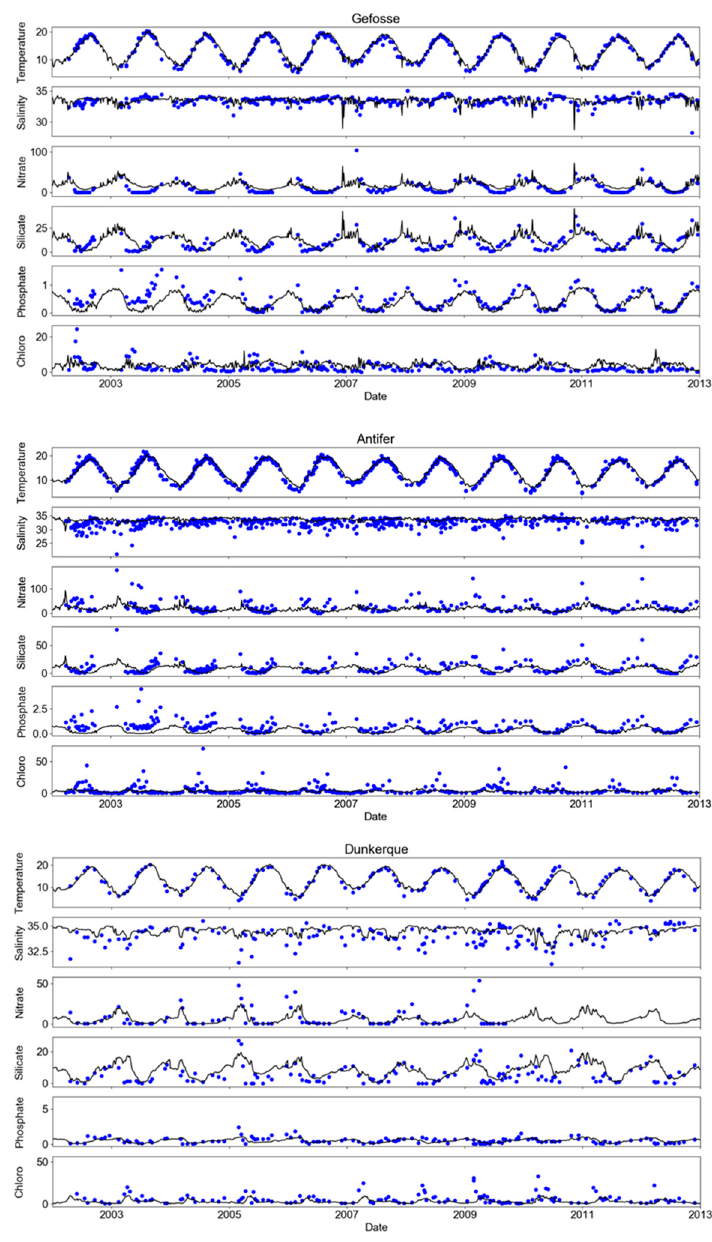
Figure 6. Seasonal and inter-annual variations of major quality variables at the coastal zone stations: Géfosse, Antifer, and Dunkerque (see locations in Figure 1). From top to bottom: temperature (°C); salinity (-); and nutrient concentrations (nitrate, silica, phosphate; µM) and chlorophyll (Chloro, µg·l − 1 ). Simulations by the ECO-MARS3D model and comparison with observations.